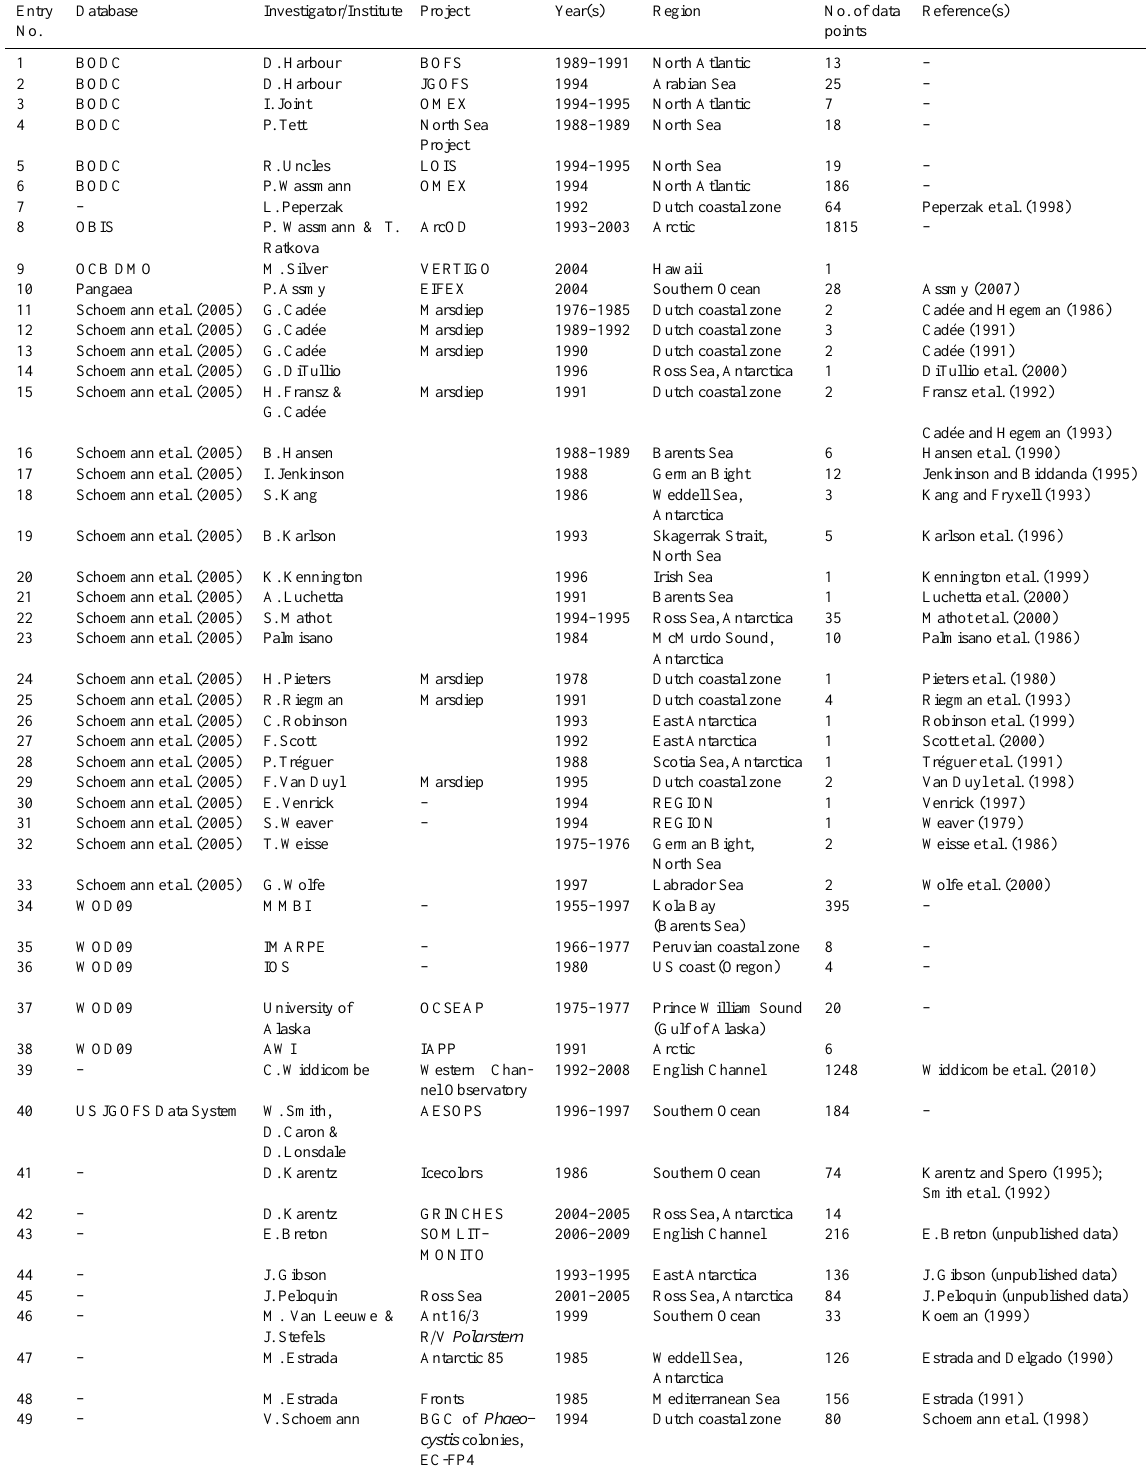
Table 1. List of data contributors, in temporal order; Databases: BODC: British Oceanographic Data Centre, OBIS: Ocean Biogeographic Information System, US JGOFS: US Joint Global Ocean Flux Study, OCB: Ocean Carbon and Biogeochemistry, WOD09: World Ocean Database 2009; Institutes: AWI: Alfred-Wegener-Institute, Bremerhaven, Germany, IMARPE: Institut del Mar del Peru, Paita, Peru,